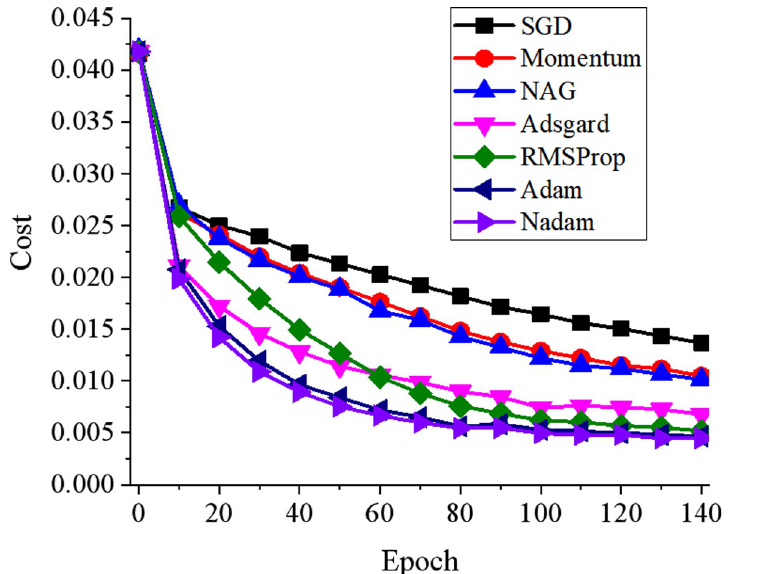
Fig 5. Comparison of the convergence speed of different optimization